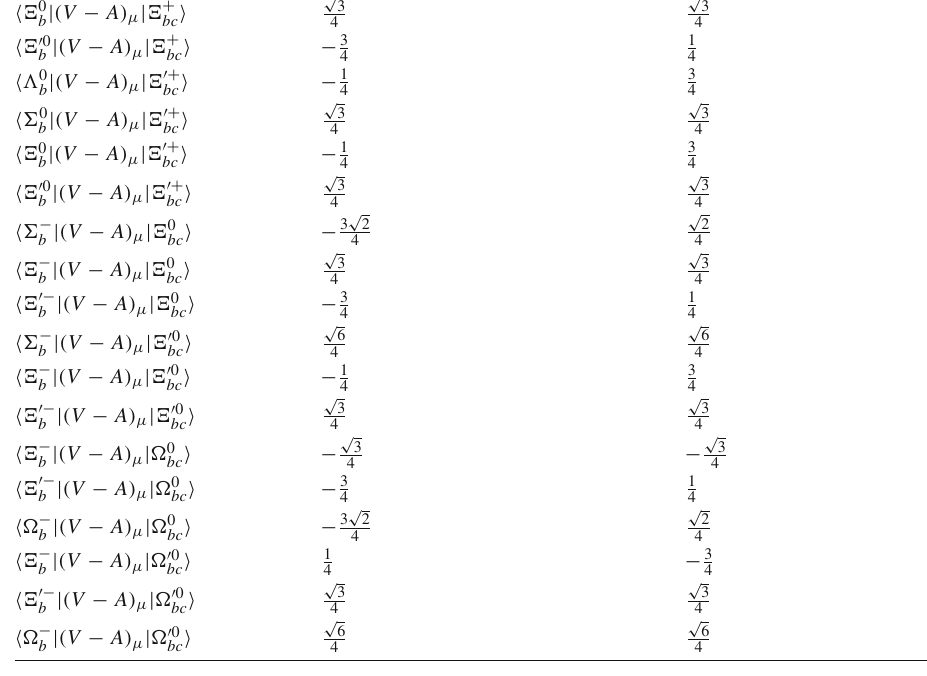
Table 6 Same as Table 3 but for the bottom–charm baryons with b